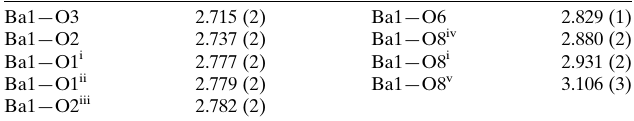
Table 3 Bond lengths (A˚ ) within the mono-capped {BaO 9 } square